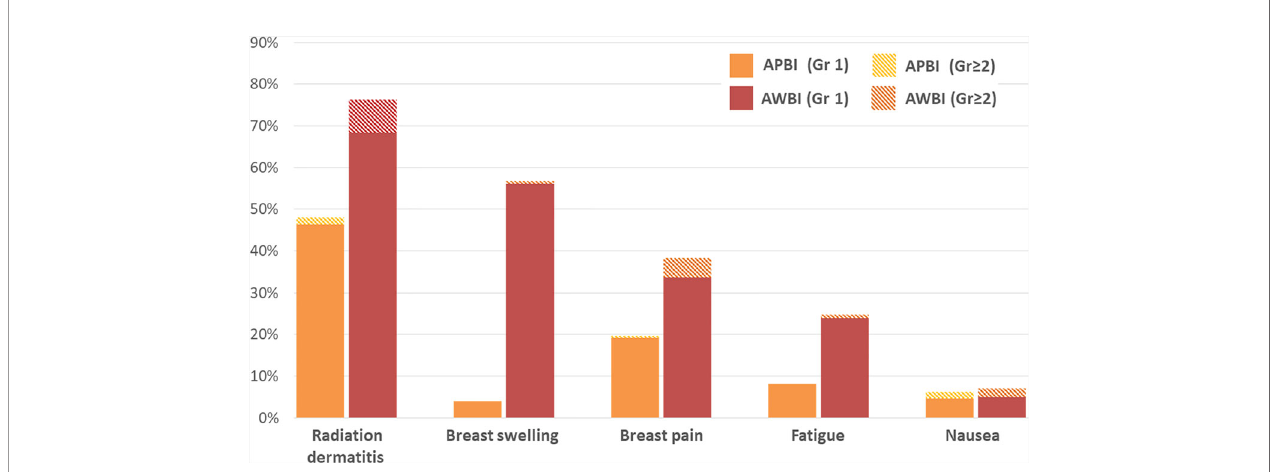
FIGURE 2 | Acute toxicities (during the radiotherapy period) by treatment